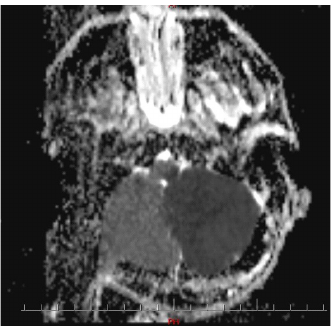
inferior cerebellar artery